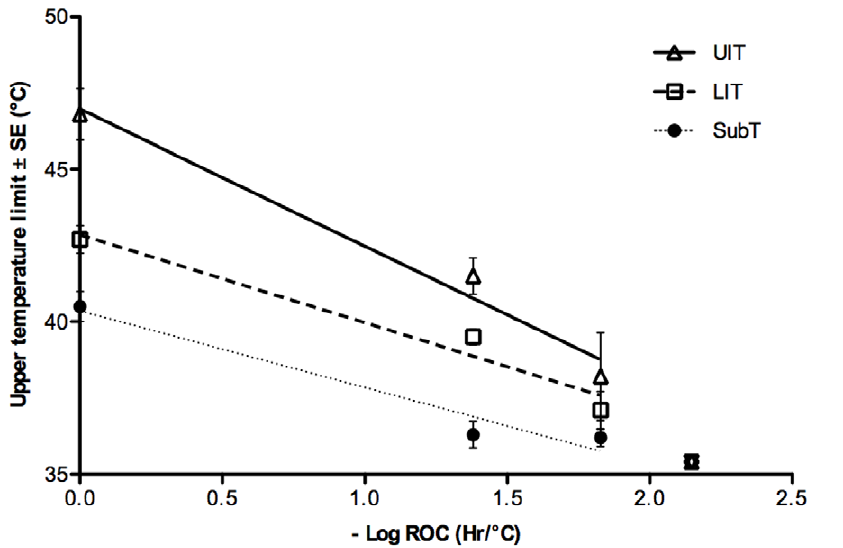
Figure 2. Effect of rate of temperature change on ULTs (Mean ± SE) of animals from different habitats: UIT (open triangle), LIT (open square) and SubT (filled circle). Error estimates for parameters are in Tables 2 and S3). UIT: y= 2 4.22x + 46.95 LIT: y= 2 2.80x + 42.87 SubT: y= 2 2.67x + 40.41. doi:10.1371/journal.pone.0029340.g002 PLoS ONE |